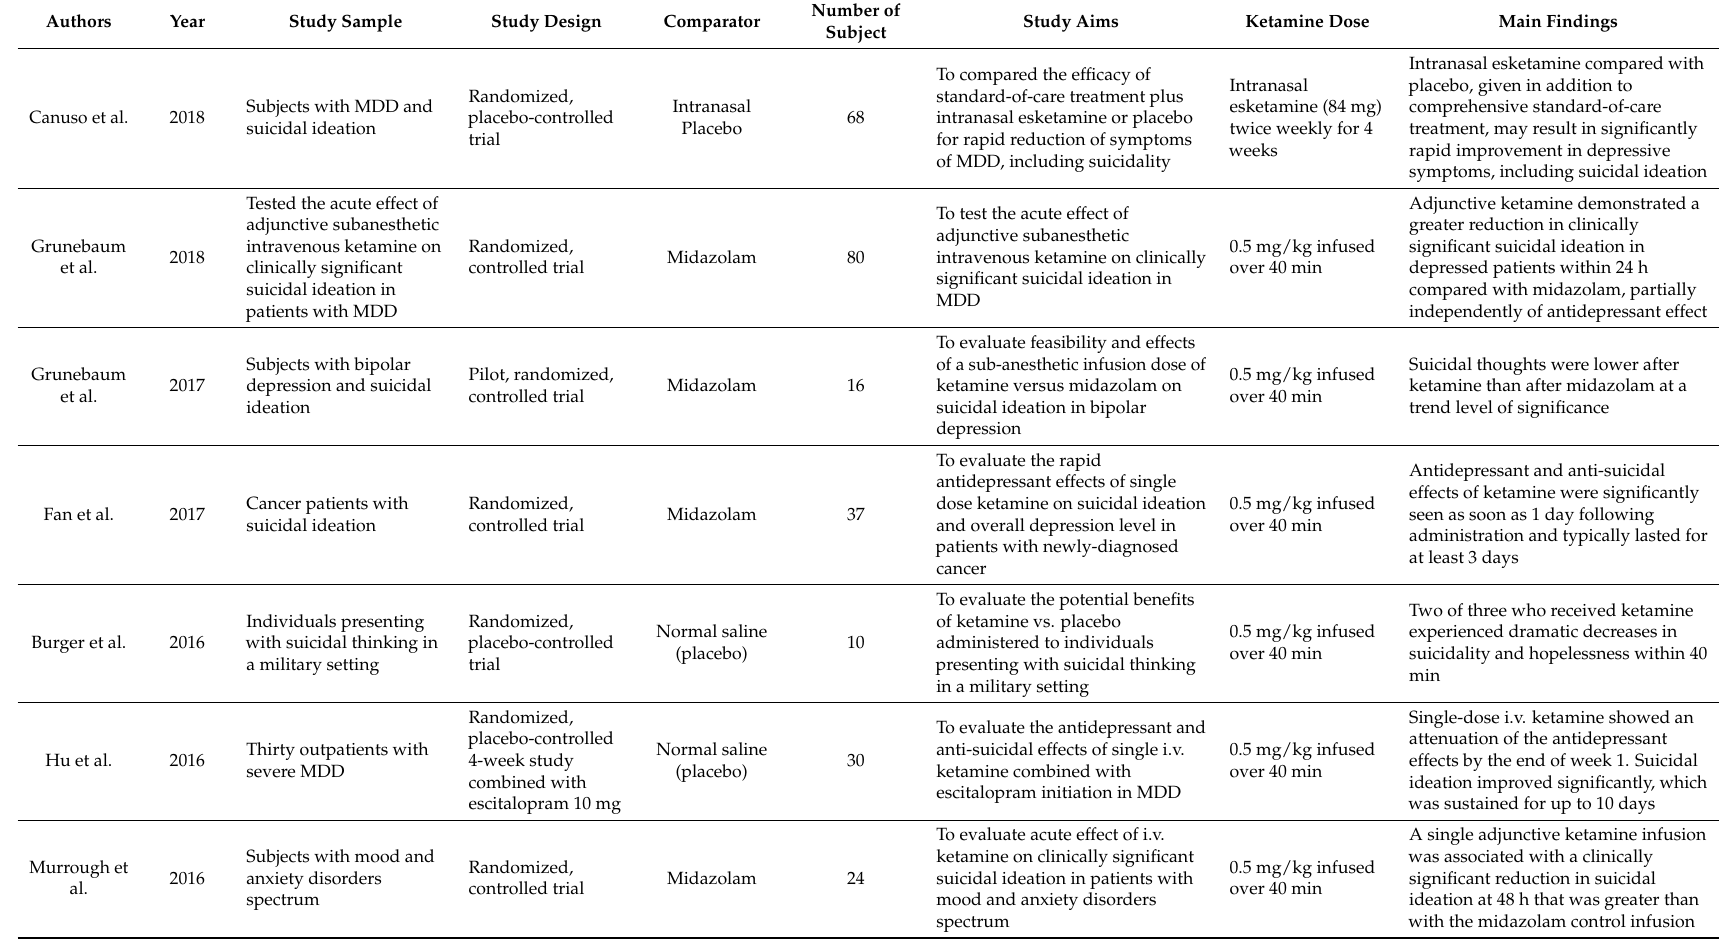
Table 1. Randomized clinical trial of ketamine and esketamine on suicide ideation and